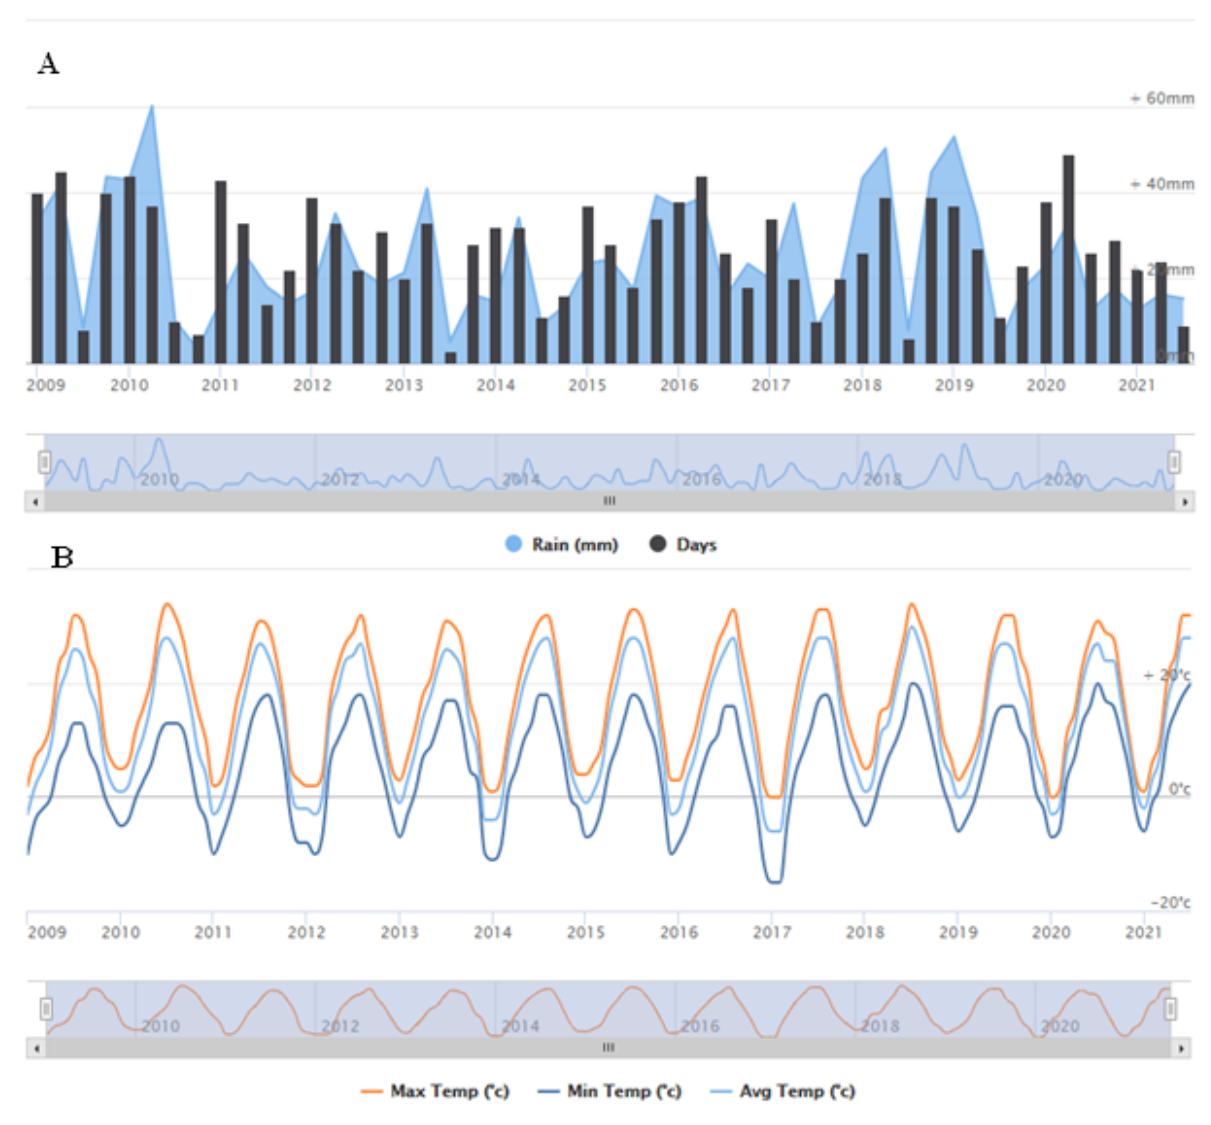
Figure 2. Annual precipitation ( A ) and temperature ( B ) trend for the ULB From 2009–2021. Annual precipitation in the ULB has been decreasing while the minimum temperatures have increased.